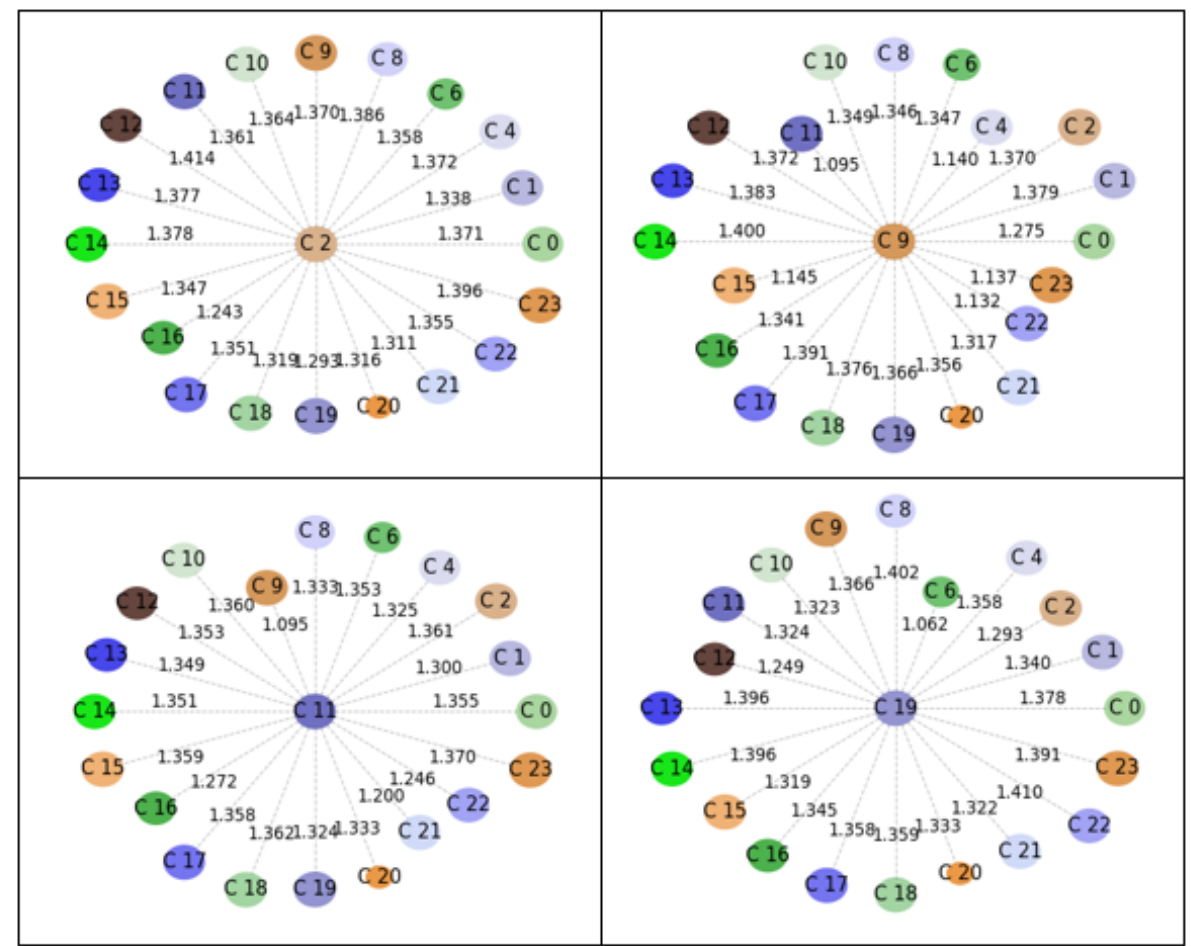
Figure 4. Distance between prominent antivaccine clusters and the rest of the